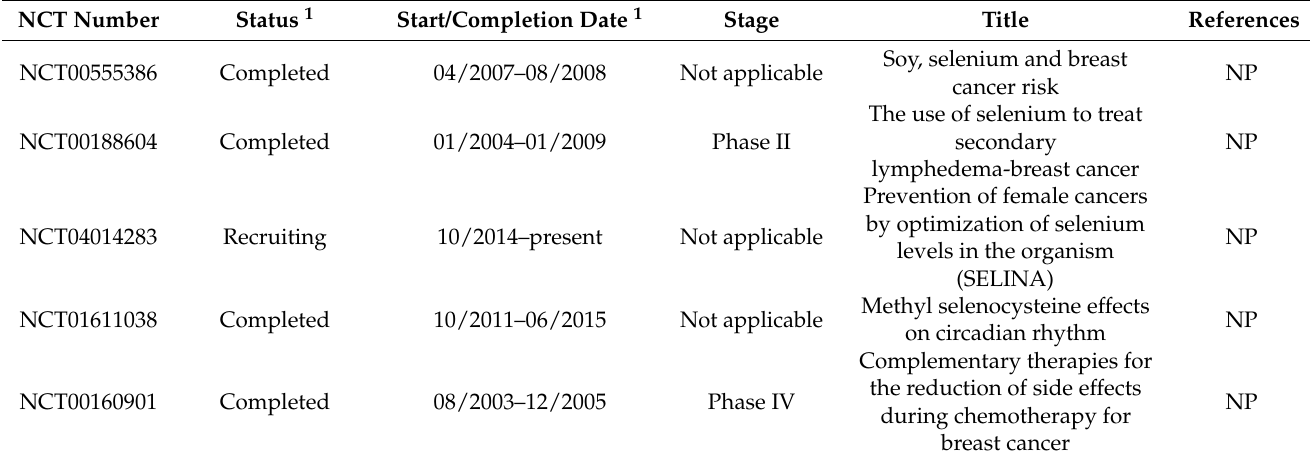
Table 10. Clinical trials with selenium in breast